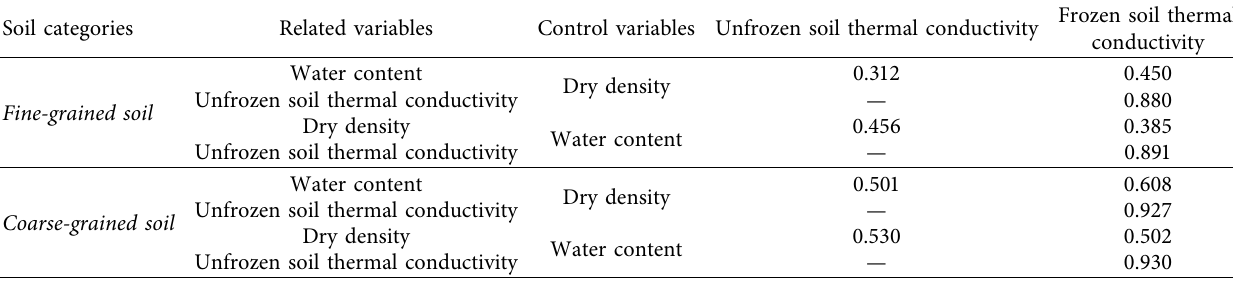
Table 2: Partial correlation analysis between frozen soil thermal conductivity, dry density, water content, and unfrozen soil thermal conductivity.